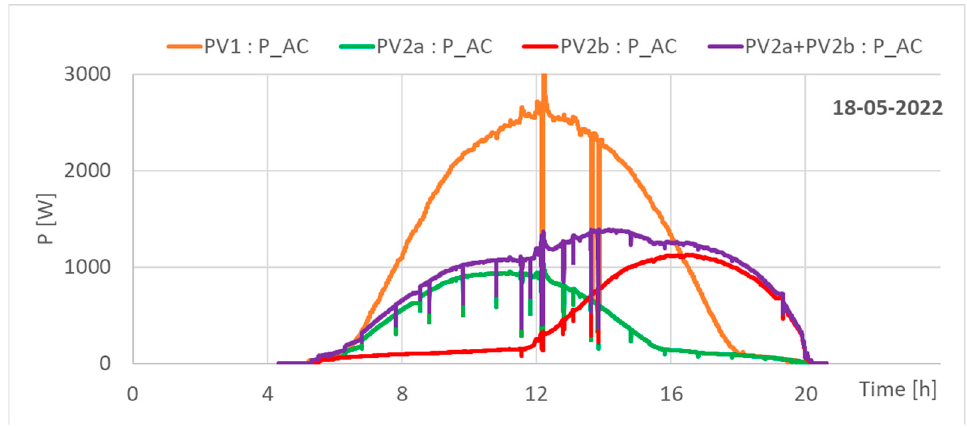
Figure 14. Instantaneous power of analyzed sections on a sunny summer day (own measurement data).